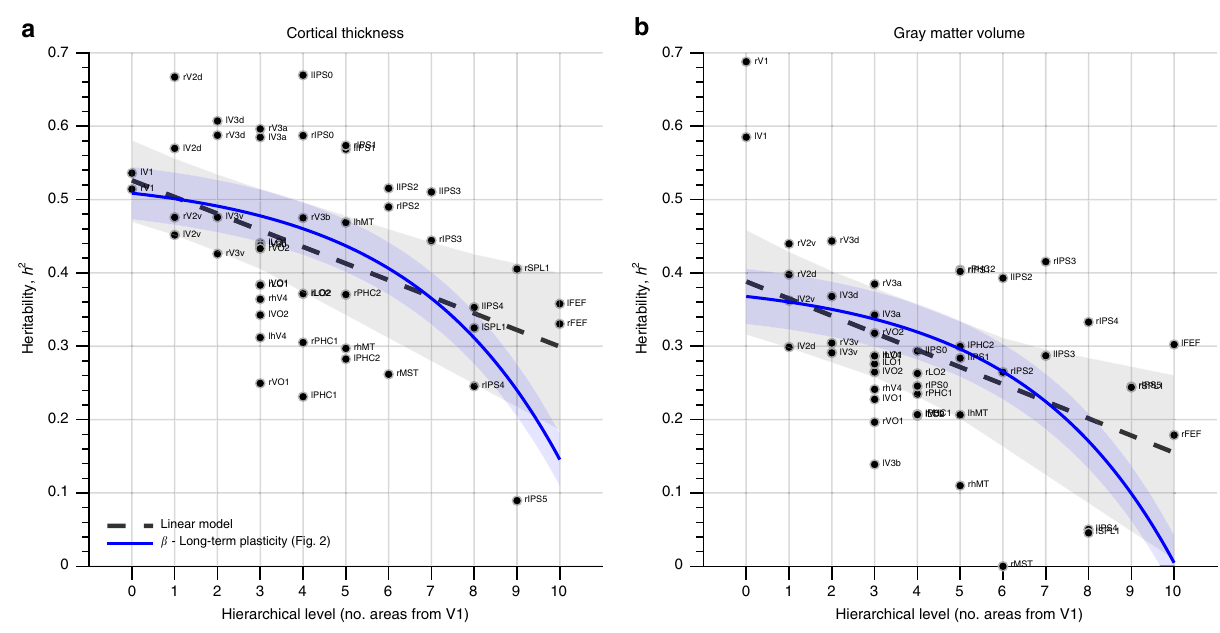
10 10 Hierarchical level (no. areas from Hierarchical level (no. areas from Fig. 4 Heritability of two anatomical phenotypes as a function of hierarchical level. The dashed gray lines and shaded areas indicate linear model fi ts and 95% bootstrapped con fi dence intervals, respectively. a The heritability of cortical thickness was negatively related to hierarchical level ( t -test, t 44 = − 3.42, p = 1.4 × 10 − 3 ) and there was no signi fi cant increase in heritability from V1 to V3 ( t -test, t = − 0.08, p = 0.93). b The heritability of gray-matter volume 8 was also monotonically and negatively related to hierarchical level ( t -tests; across all areas: t 44 = − 3.62, p = 7.5 × 10 − 4 ; from V1 to V3: t 8 = − 3.34, p = 0.01). These results are consistent with the theoretical model presented in Fig. 2, because purely anatomical phenotypes are presumably not strongly in fl uenced by short-term plasticity. The thick blue lines and blue shaded areas indicate the fi ts of the long-term plasticity component and 95% con fi dence intervals (only the intercept was fi tted, the other parameters were fi xed as the estimates based on fi tting the full two-component model to the RSFC heritability data shown in Fig. 2b). Source data are provided as a Source Data fi le